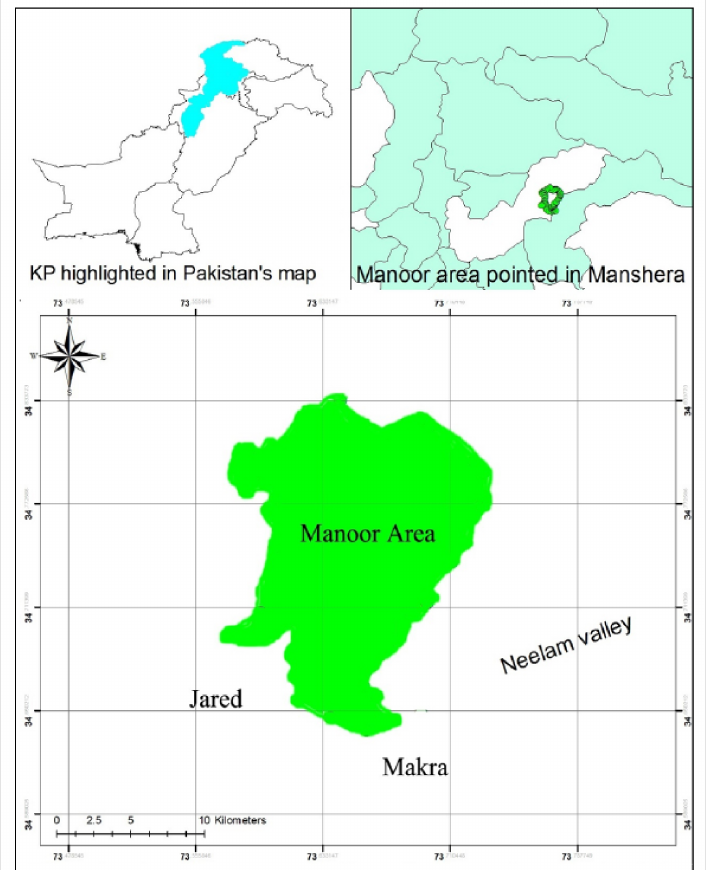
Figure 1. Map of the study area (Manoor Valley/Area) generated by ArcGIS